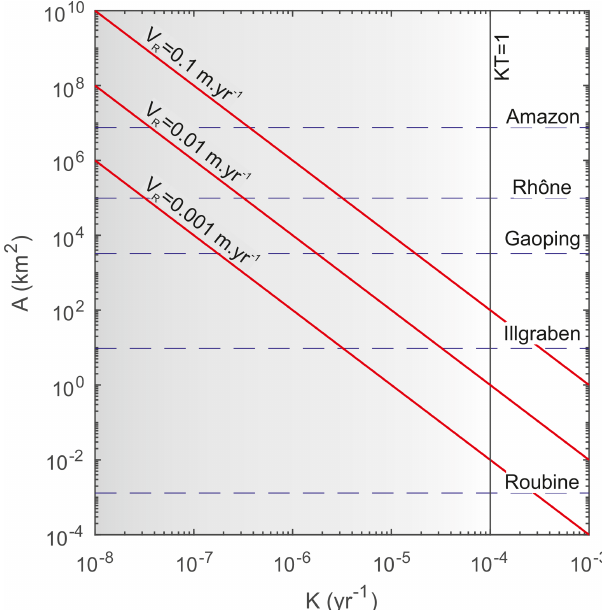
Figure A1. Range of possible couples of parameters of river drainage area A and erodibility K for different values of retreat rate V R (red lines). The vertical black line indicates the uppermost value of K , as KT (cid:28) 1. The range of acceptable values of K is indicated by a gradient from white (non-acceptable) to grey (ac- ceptable). The drainage area A of some iconic catchments is indi- cated with dashed blue lines and includes the Amazon (South Amer- ica), Rhône (Europe), Gaoping (Taiwan), Illgraben (Switzerland) and Roubine (France)